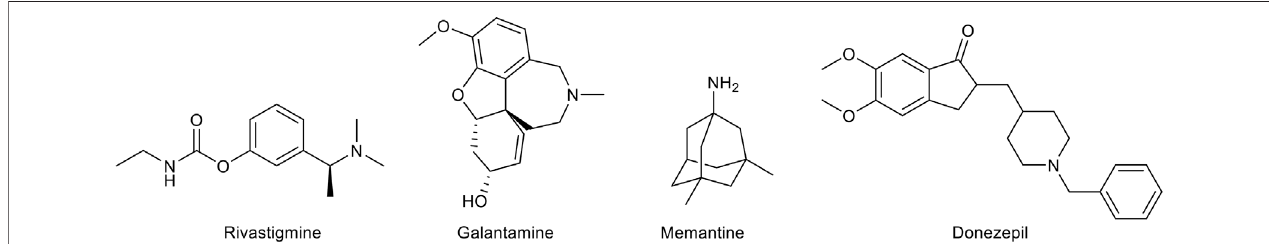
FIGURE 2 | Chemical structures of the approved drugs for Alzheimer ’ s disease